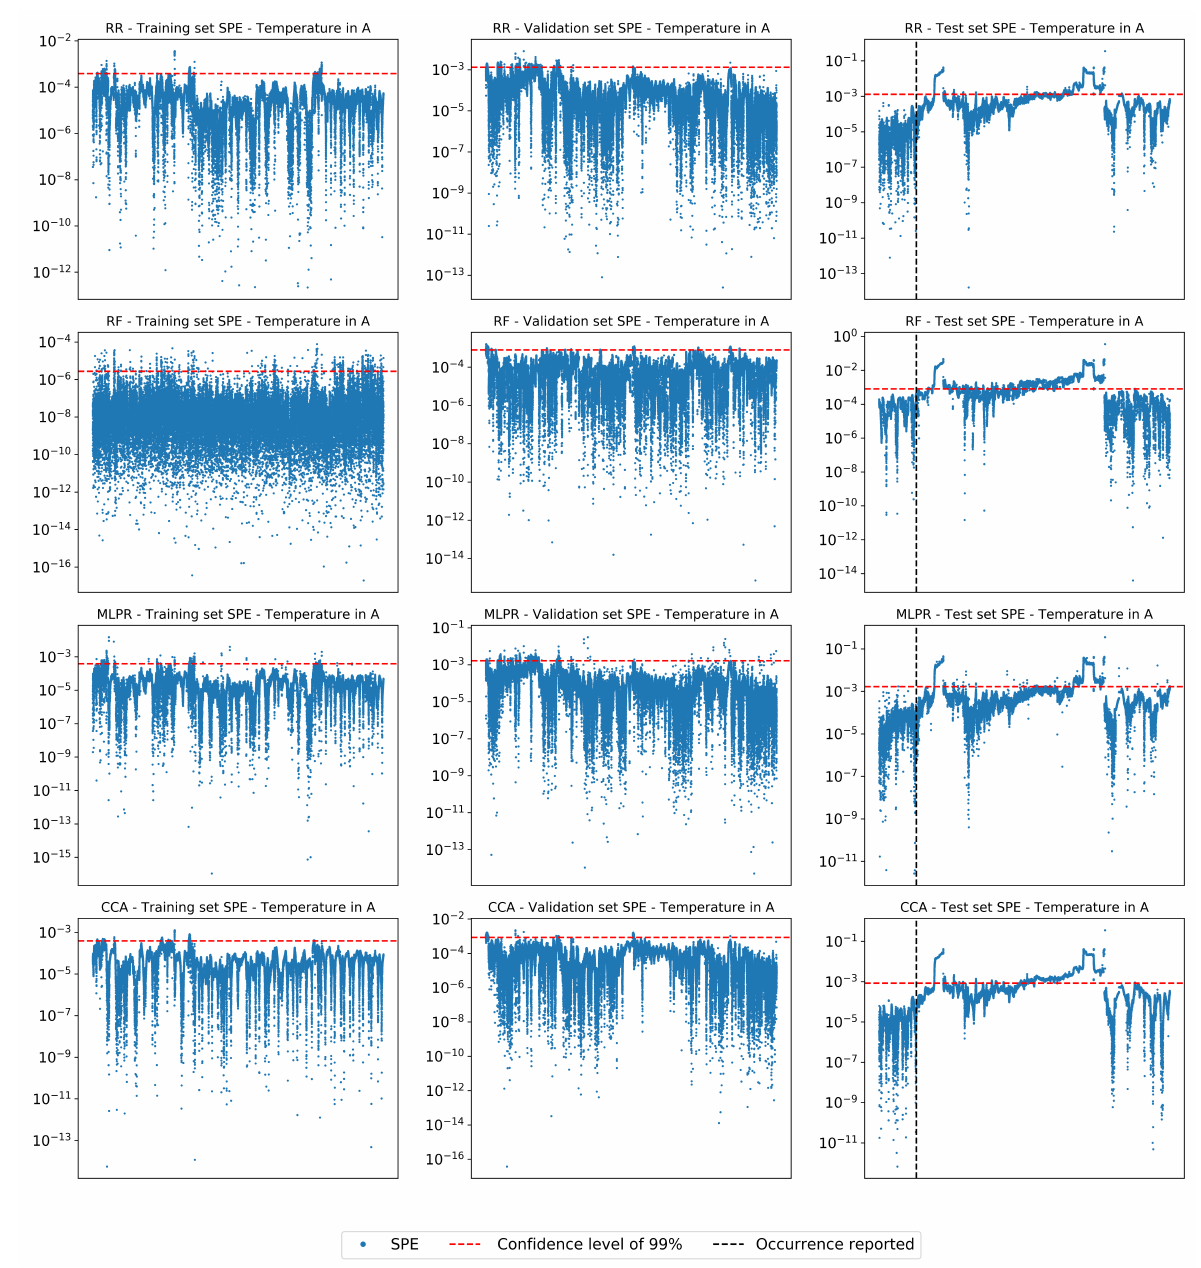
Figure 5. Fault detection index SPE along Fault-FII when the PCStable algorithm (partial correlation) with MCI (conditional mutual information) was used as the variable selection